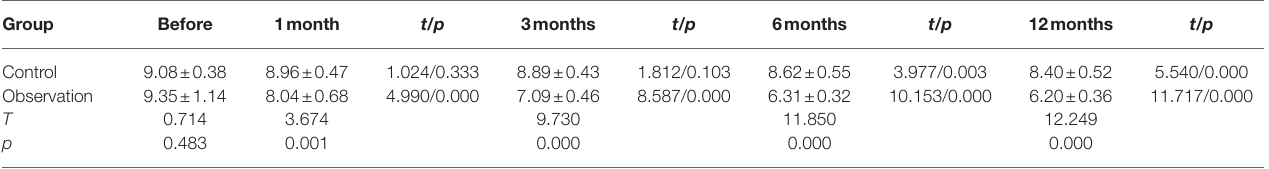
TABLE 6 | The serum HbA1c levels in the two groups before and after ABMI (mean ± SD, mmol/L). Group Before 1 month t/p 3 months t/p 6 months